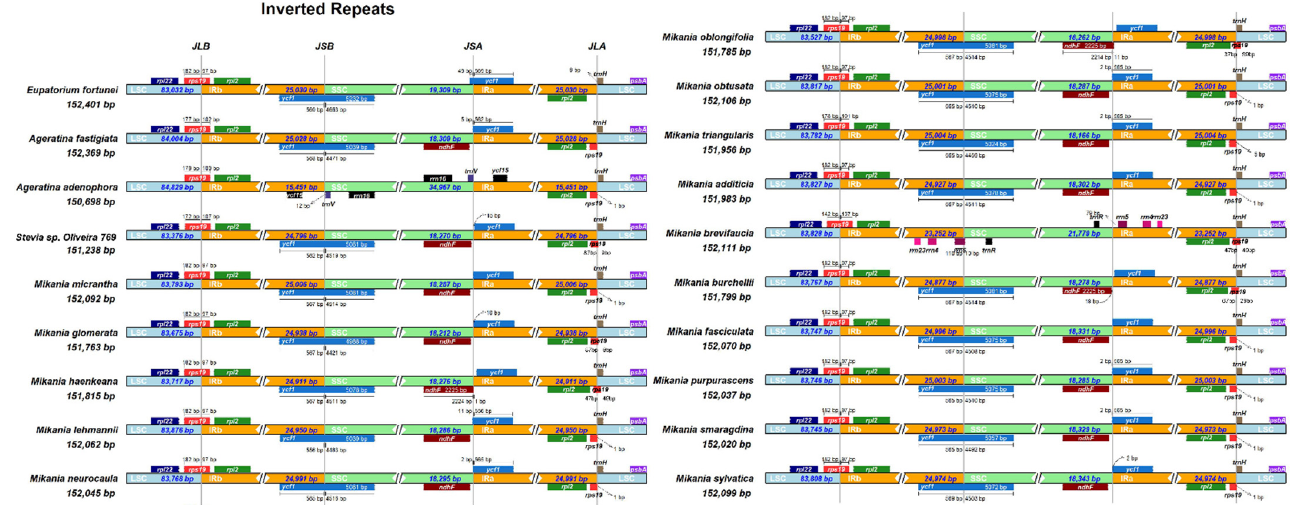
Figure 6. Comparison of LLC, IR, and SSC border regions among 19 Eupatorieae chloroplast genomes. (The light blue, yellow, and grass green blocks represent the LSC, IR, and SSC regions, respectively. JSA: junction of the SSC and the IRA; JLB: junction of the LSC and the IRB; JSB: junction of the SSC and the IRB. Boxes above or below the main line indicate genes adjacent to borders.)